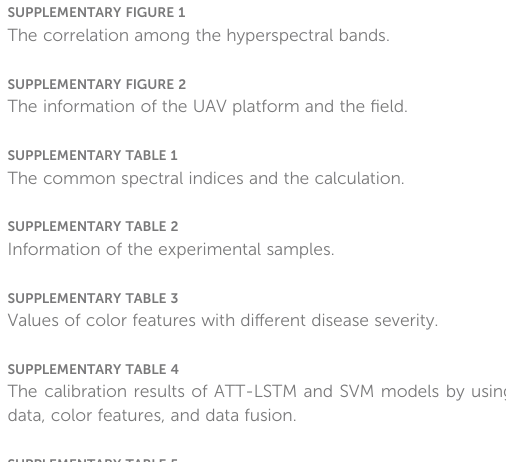
SUPPLEMENTARY FIGURE 1 The correlation among the hyperspectral bands. SUPPLEMENTARY FIGURE 2 The information of the UAV platform and the fi eld. SUPPLEMENTARY TABLE 1 The common spectral indices and the calculation. SUPPLEMENTARY TABLE 2 Information of the experimental samples. SUPPLEMENTARY TABLE 3 Values of color features with different disease